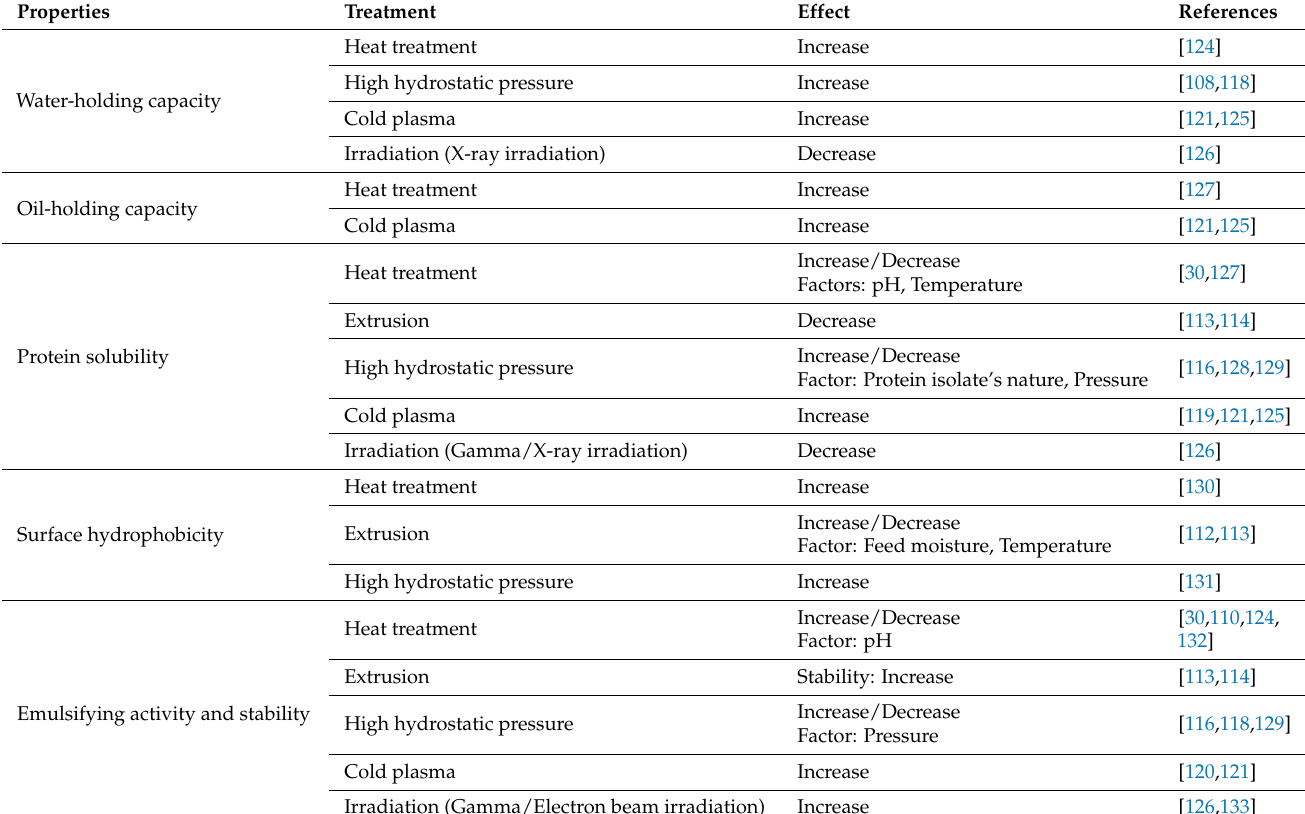
Table 3. Effect of processing on the functional properties of legume protein